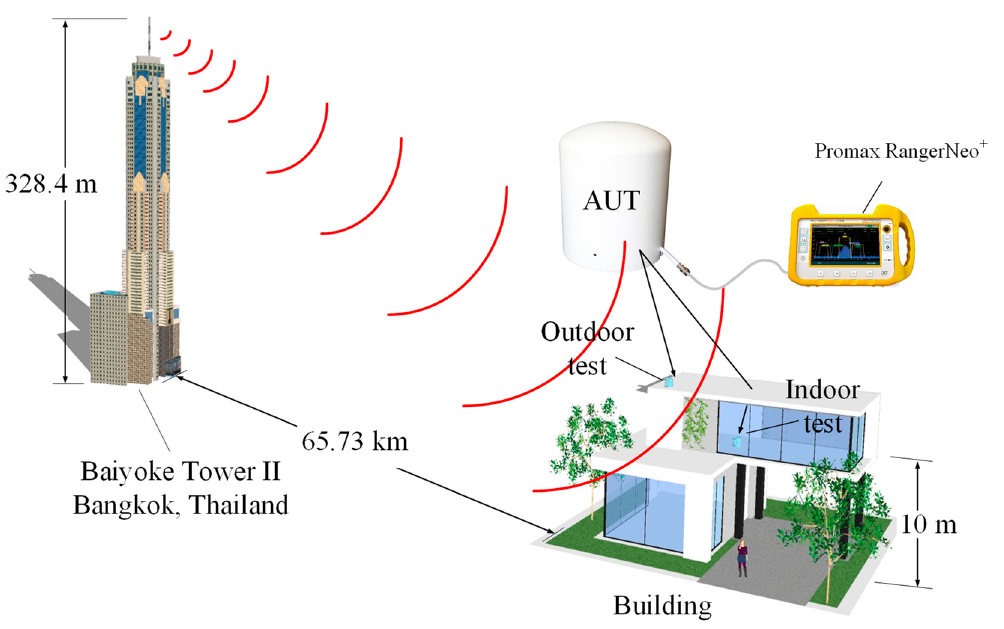
Figure 21. The portable wideband directional antenna scheme with a DVB signal receiver.